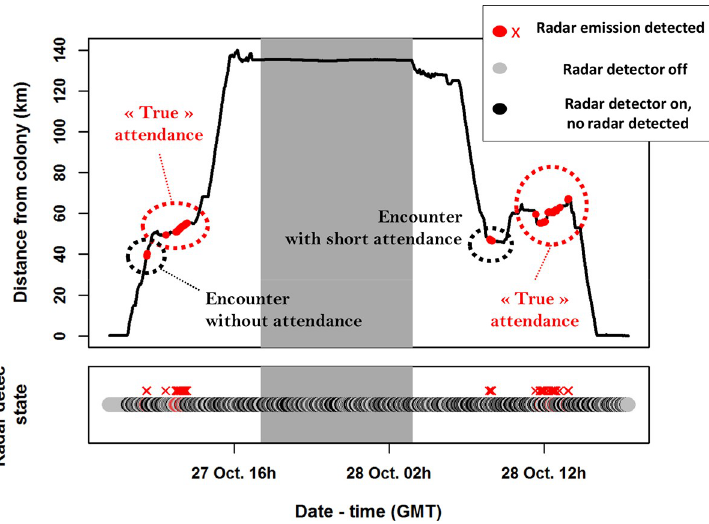
Fig 1. Example of radar detector data along a Cape gannet foraging trip recorded by a XGPS. Grey shaded areas correspond to night time. Four « encounters » separated from each other by more than 1h without radar detection were identified. Definitions for the different categories of encounters are provided in the Results